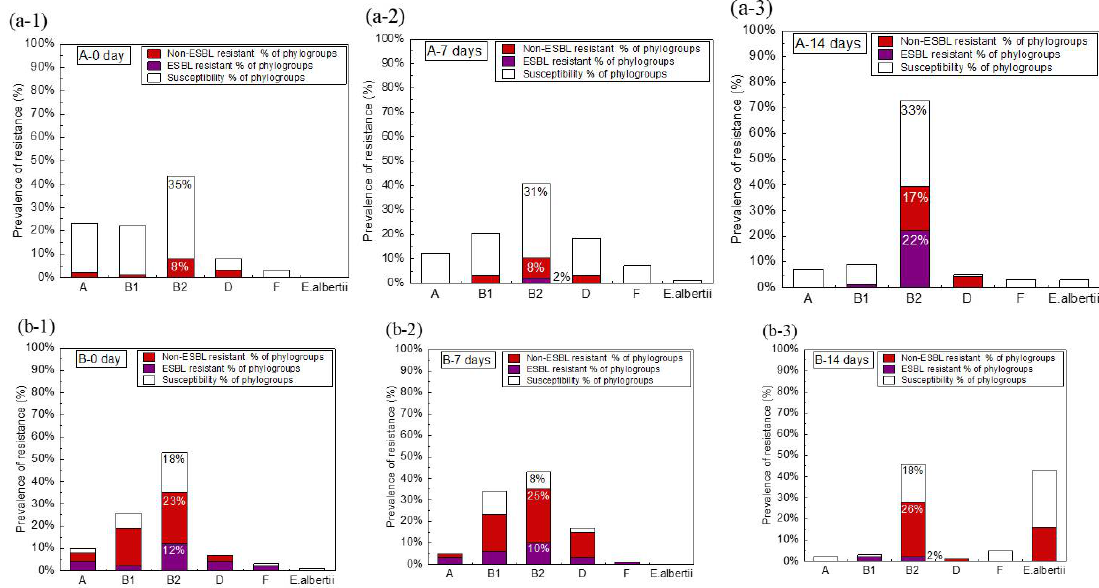
Figure 3. The relationship between phylogroups and antibiotic resistance (ESBL and non-ESBL) of E. coli isolates in wastewater samples collected from plants A and B. E. coli isolates obtained from plant A samples on days 0 ( a-1 ), 7 ( a-2 ), and 14 ( a-3 ). E. coli isolates obtained from plant B on days 0 ( b-1 ), 7 ( b-2 ), and 14 ( b-3 ).